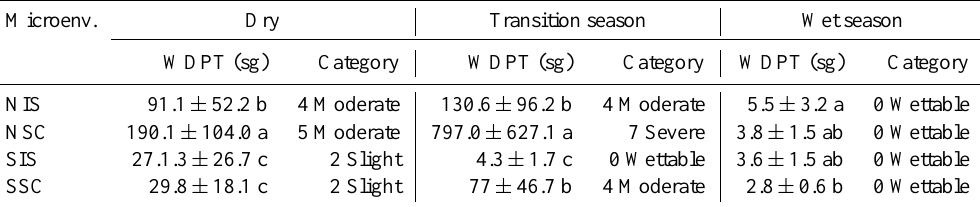
Table 3. Quantitative and qualitative values of SWR. Microenv.: microenvironment; WDPT: water drop penetration time; NIS: north-facing inter-shrub; NSC: north-facing shrub-covered; SIS: south-facing inter-shrub; SSC: south-facing shrub-covered. Different letters denote sig- nificant differences between microenvironments in every season. Microenv.